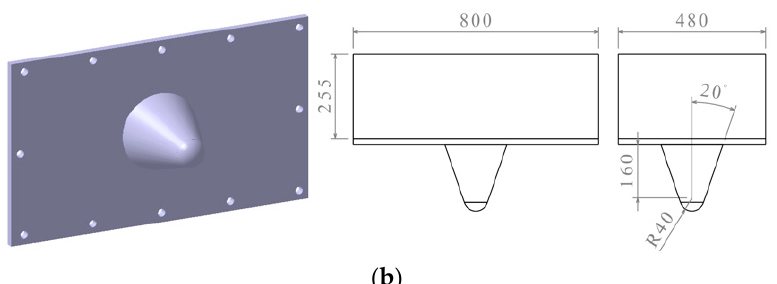
Figure 5. Striker dimensions: ( a ) knife-edge striker; ( b ) conical striker with a hemispherical tip.